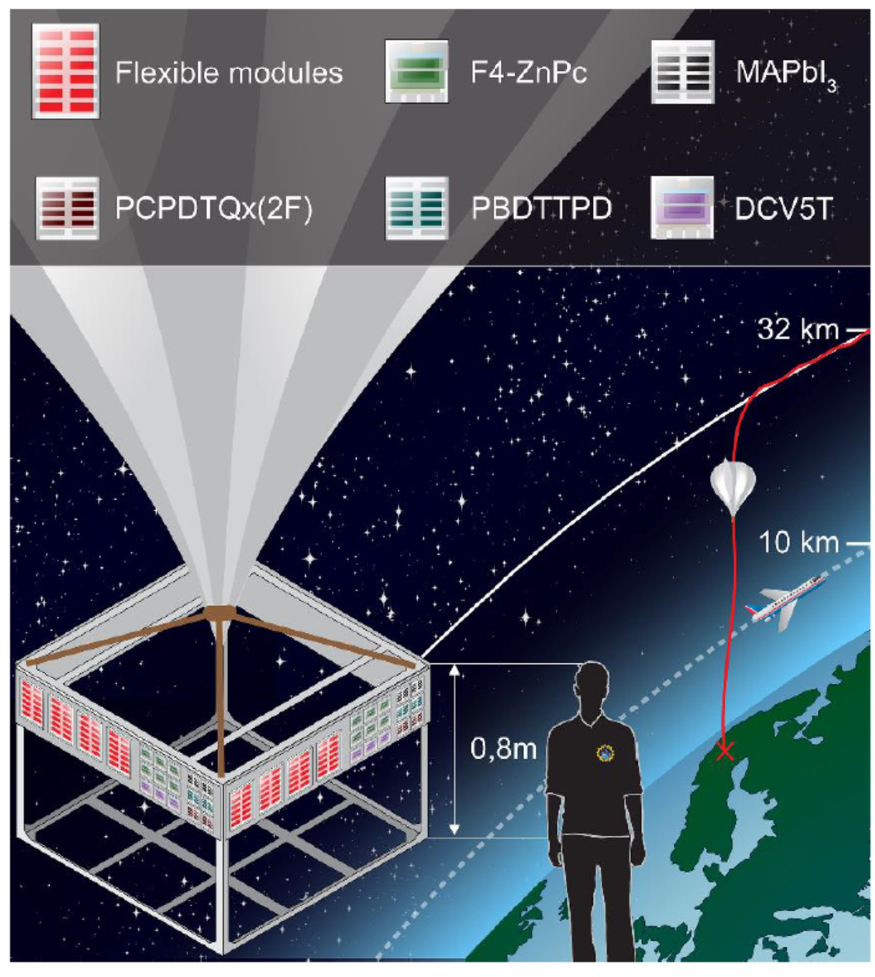
Figure 17. Schematical illustration of the experimental setup and selected experimental details.